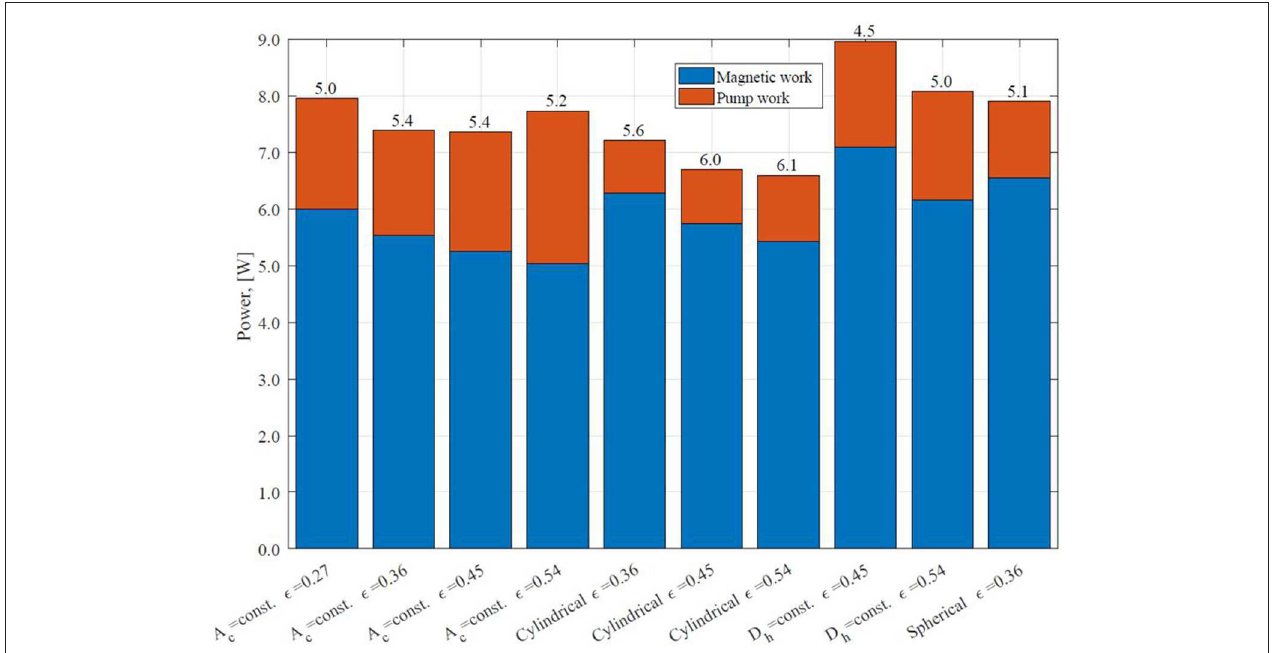
FIGURE 12 | Total power consumption of AMR that demonstrates cooling COP > 4.0 at Q cool = 40W (from Table 4